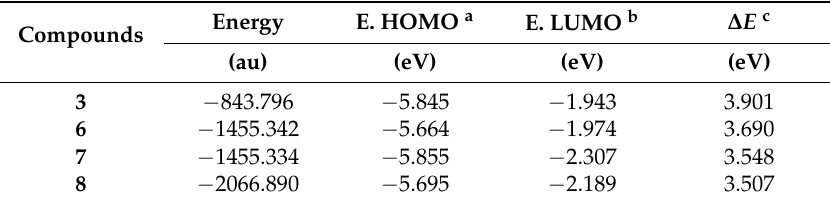
Figure 2. HOMO-LUMO gaps of chalcone derivatives 3 and 6 – 8 .